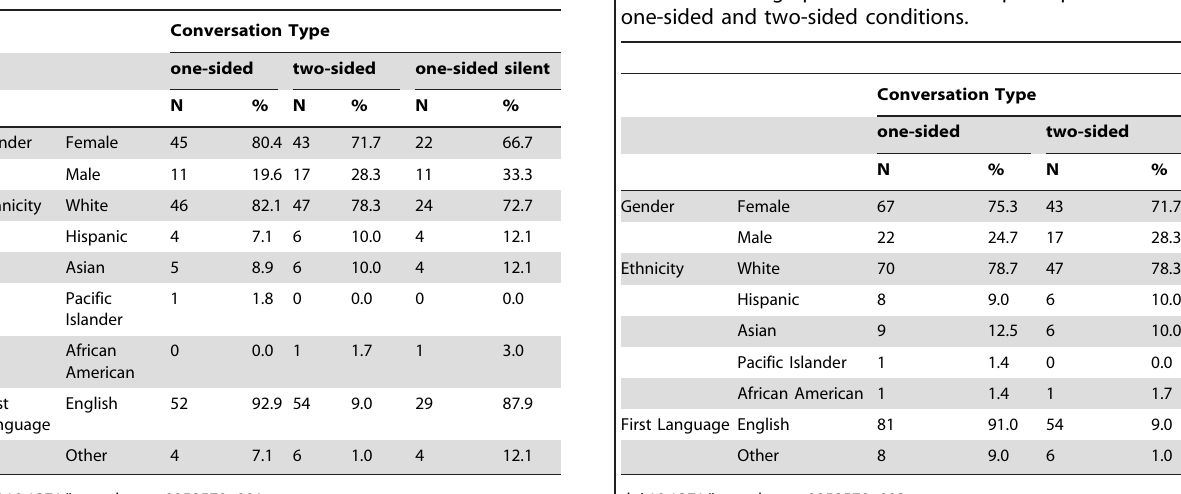
Table 3. Demographic information for participants in